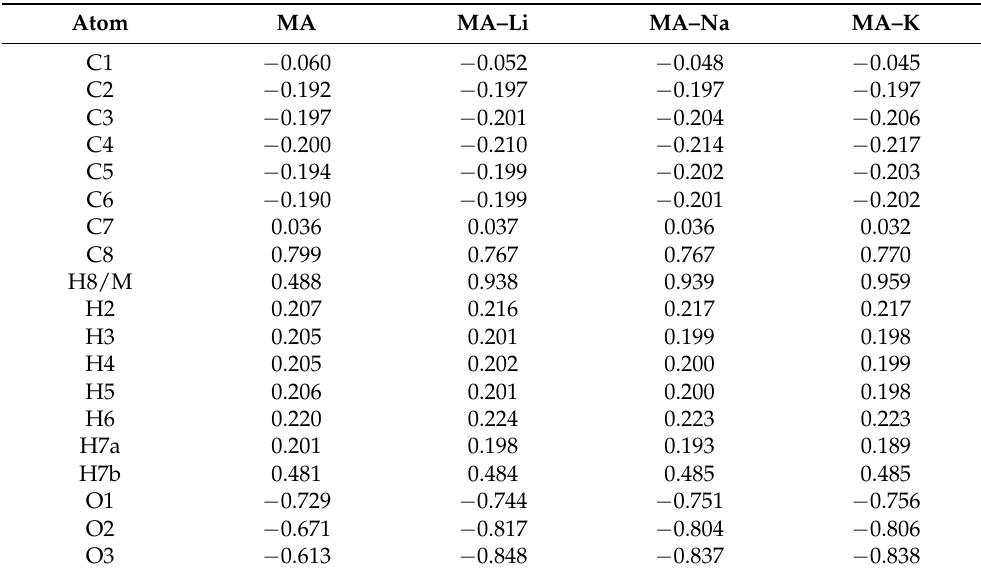
Table 5. NBO analysis for mandelic acid and its salts with lithium, sodium, and potassium (calculated in